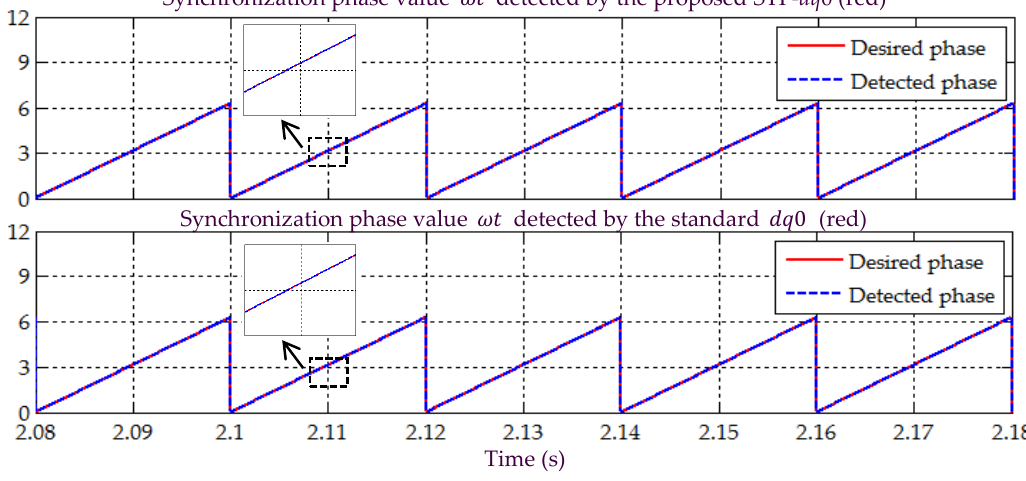
Figure 5. Simulation result showing the detected synchronization reference phase value 𝜔𝑡 under Scenario A.